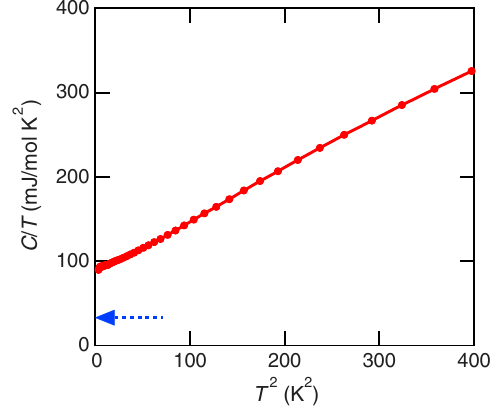
FIG. 4. C=T vs T 2 for YCo 5 , from which we obtain the Sommerfeld coefficient γ in the T → 0 limit. The dashed arrow is the value expected based on the band